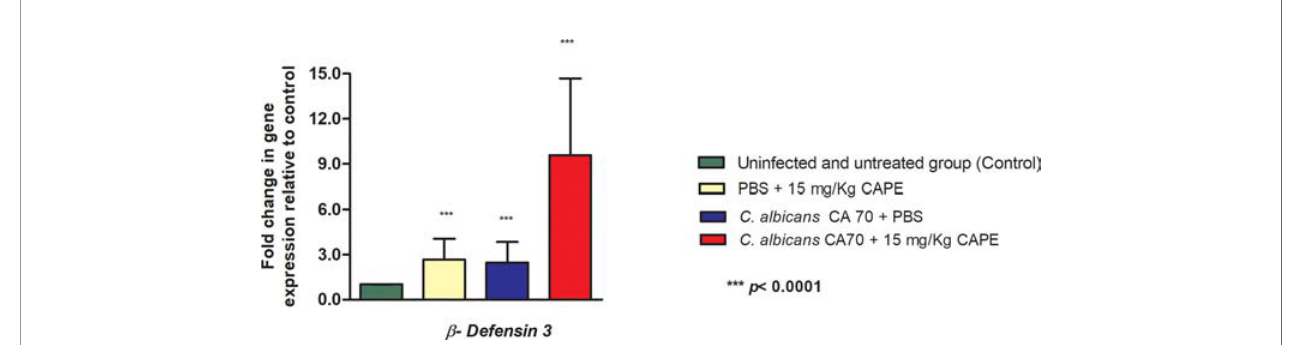
FIGURE 12 | CAPE increased the expression of b -defensin 3 gene. Relative quanti fi cation (log) of b -defensin 3 gene for the uninfected and untreated group (control), infected with CA70 only, treated with CAPE, and infected with CA70 + CAPE (15 mg/Kg). Gene expression was represented as mean and SD. Normalization was done using b -actin gene. ANOVA and Tukey Test (*** p